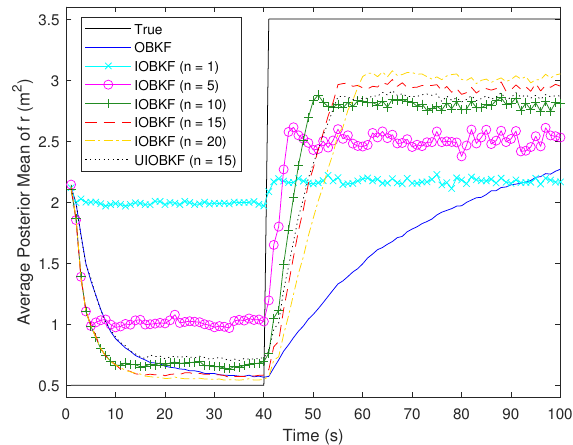
Figure 12. Estimation of noise parameter r